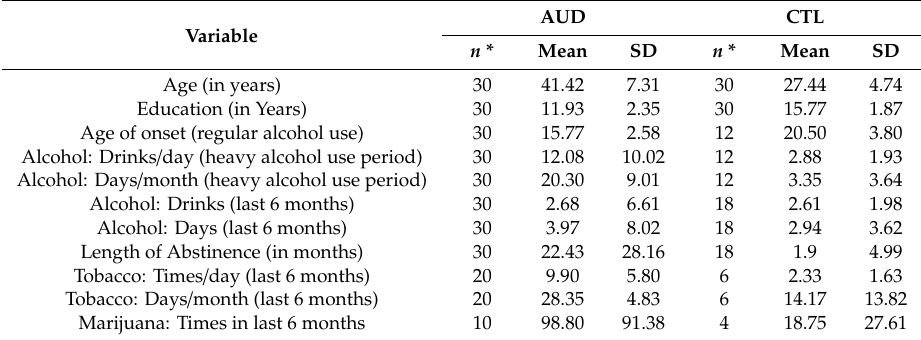
Table 1. Demographic and clinical characteristics of the